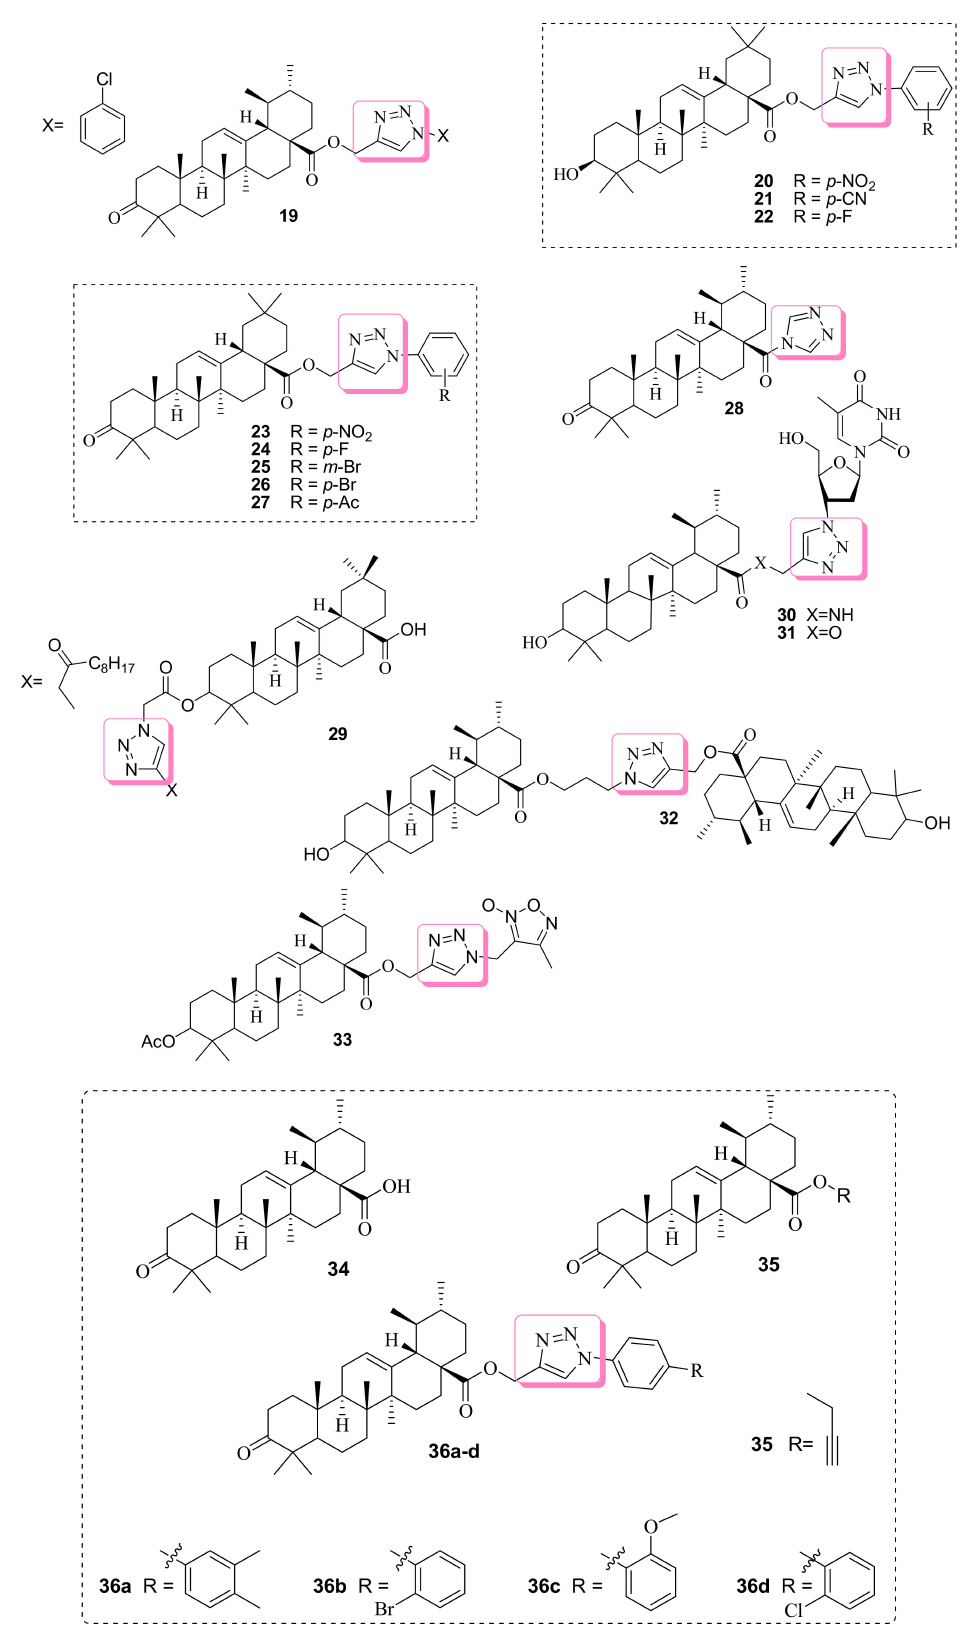
Figure 3. Ursolic acid and oleanolic acid-based triazole hybrid